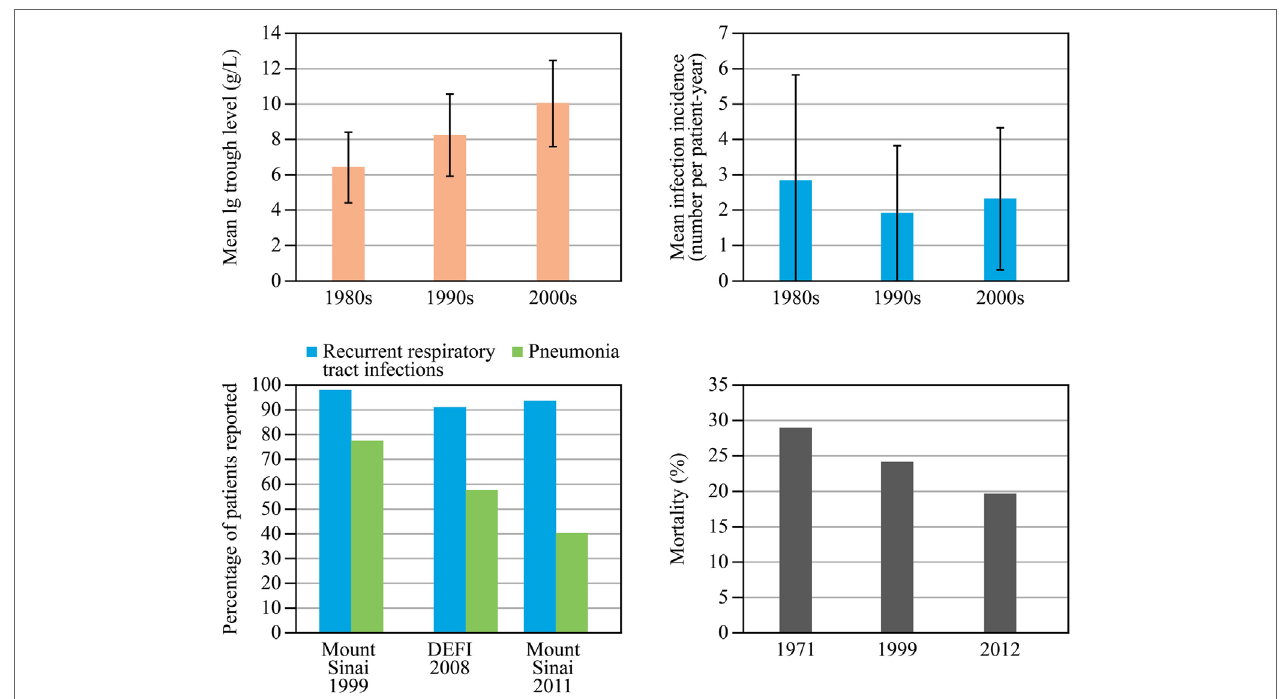
FigURe 1 | Development of immunoglobulin replacement therapy and infection rates since 1990s. Data for immunoglobulin (Ig) trough levels (top left) and infection rates (top right) are from a cohort of 115 patients with common variable immunodeficiency (CVID) or X-linked agammaglobulinemia reported by Lucas et al. (1). A combined analysis of data on the percentage of patients experiencing pneumonia and recurrent respiratory tract infections (bottom left) is shown in three large series of CVID patients in 1999, 2008, and 2011 (two from the same cohort in the United States 12 years apart, 248 and 252 patients, and one from a French cohort, 473 patients); reproduced with kind permission from 2014 British Society for Immunology, Clinical and Experimental Immunology, 178: 67–69 (2). Mortality data (bottom right) for 1971 are from Healy et al. (6); those for 1999 and 2012 are from a single cohort follow up reported by Resnick et al. (7). DEFI, a French national study. Abbreviation: PAD, primary antibody